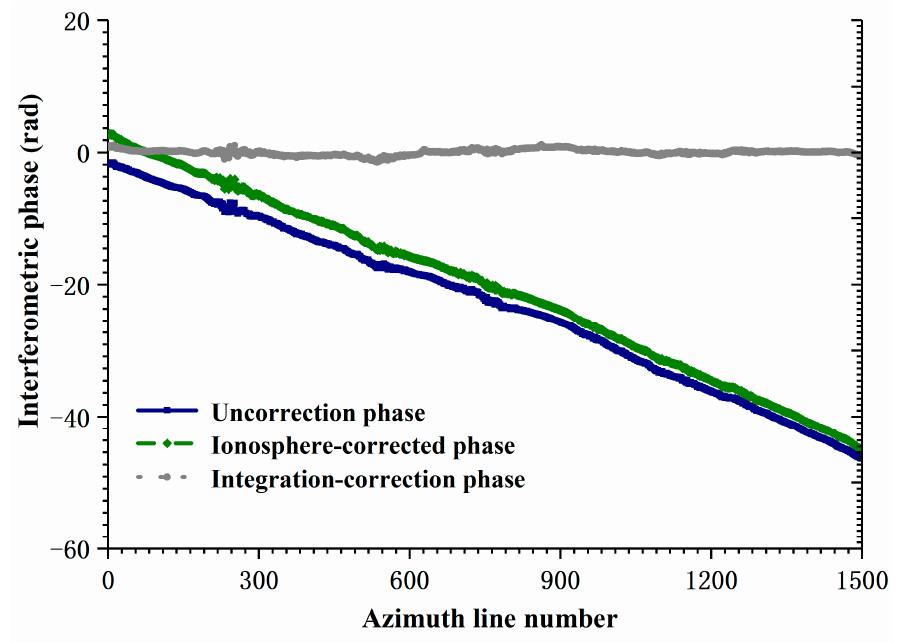
Figure 12. Comparison among the interferometric phase in the profile B-B’ in Figure 11a,c,d.